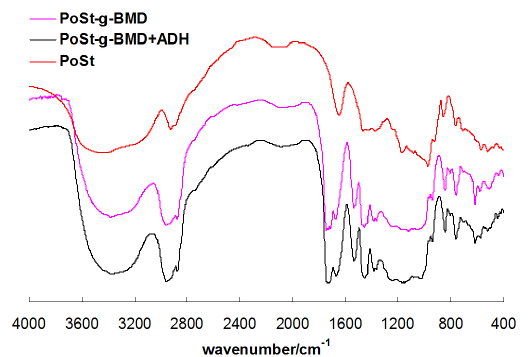
Figure 9. Thermo gravimetric analysis (TGA) of PoSt, PoSt-g- BMD and PoSt-g-BMD+ADH